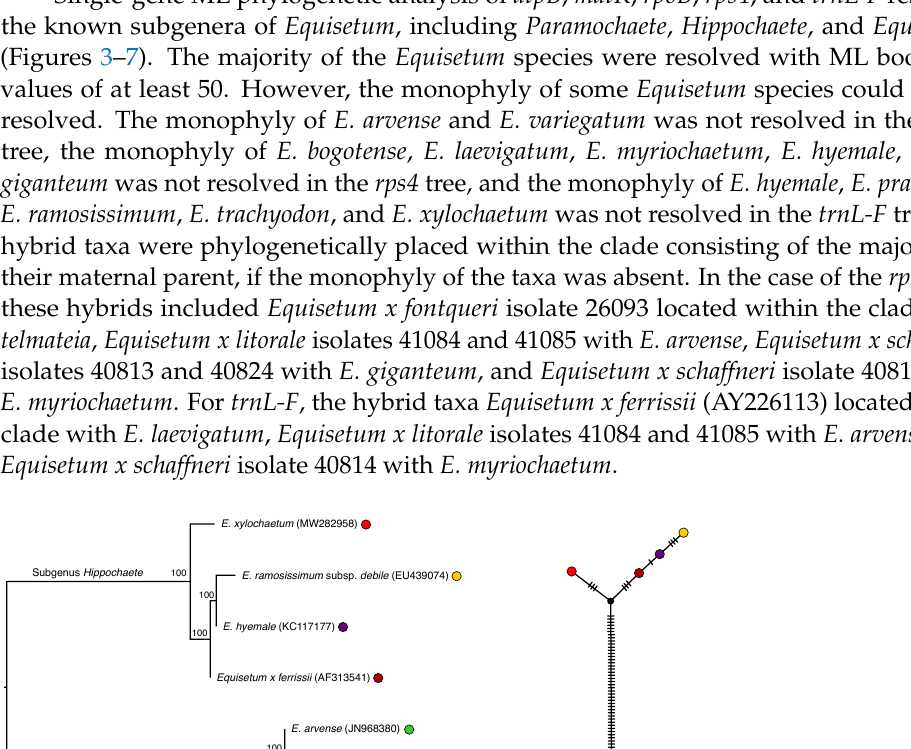
Figure 2. Maximum-likelihood tree inferred from all Equisetum plastome protein-coding regions using a GTR+I+F model. The scale bar represents the estimated number of nucleotide substitutions per site. The bootstrap and posterior probability values are reported at the respective nodes. The values include the ML bootstrap values of nucleotide and protein data and the BI posterior probability of the nucleotide and protein data, respectively.